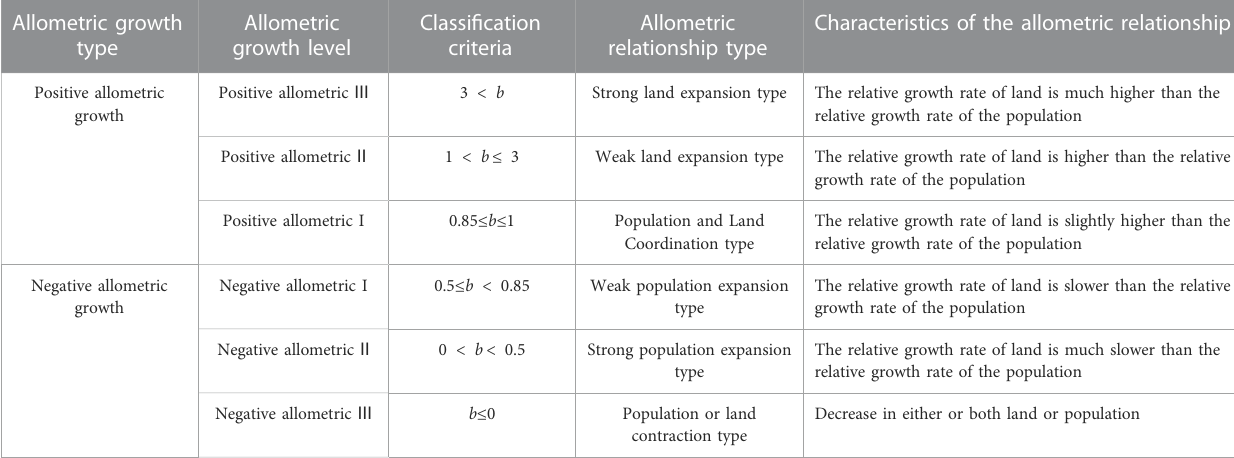
TABLE 2 The classi fi cation table of the allometric relationship between population and land.